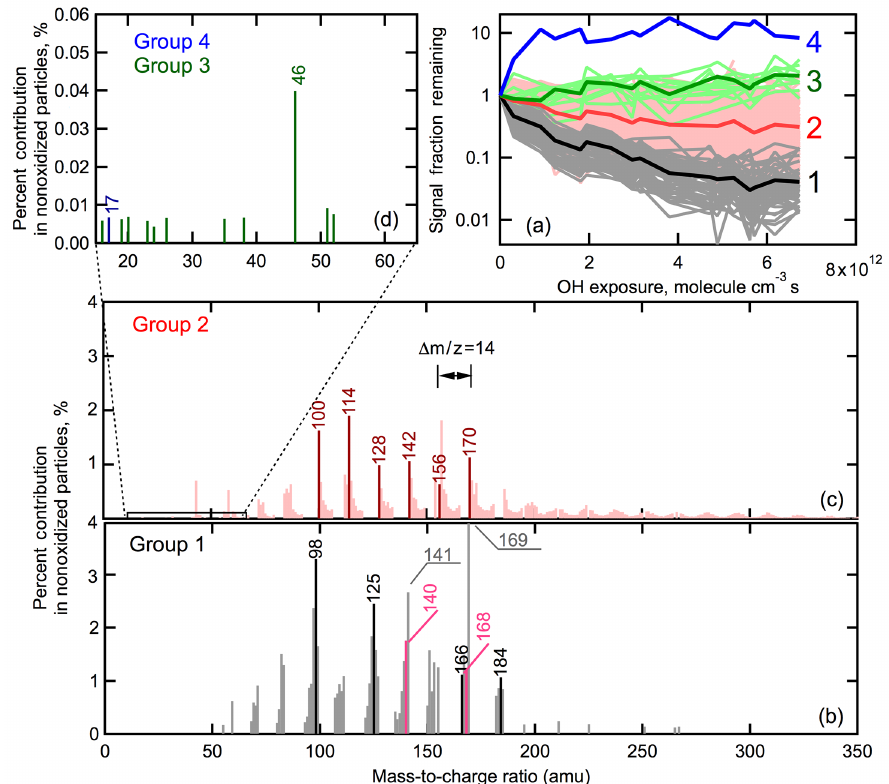
Figure 7. (a) Categorization of peaks according to their decay with OH exposure for high-RH experiments. The peaks were classified into four groups. Peaks in Group 1 (gray) exhibit the fastest decay, with the average shown as the solid black curve. The peaks in Group 2 (red) exhibit the second fastest decay, with the average shown in dark red curve. The peaks in Group 3 (green) exhibit negligible decay, with the average shown in dark green. Group 4 (blue) contains only one peak. (b) Spectrum of the peaks in Group 1. Group 1 contains markers from cis -pinonic acid (black peaks) and pinic acid (pink peaks). (c) Spectrum of the peaks in Group 2. Group 2 contains patterns of repeating peaks separated by (cid:49)m/z = 14, illustrated by dark red peaks. (d) A zoomed-in view of the peaks of Group 3 and Group 4. These peaks have very small